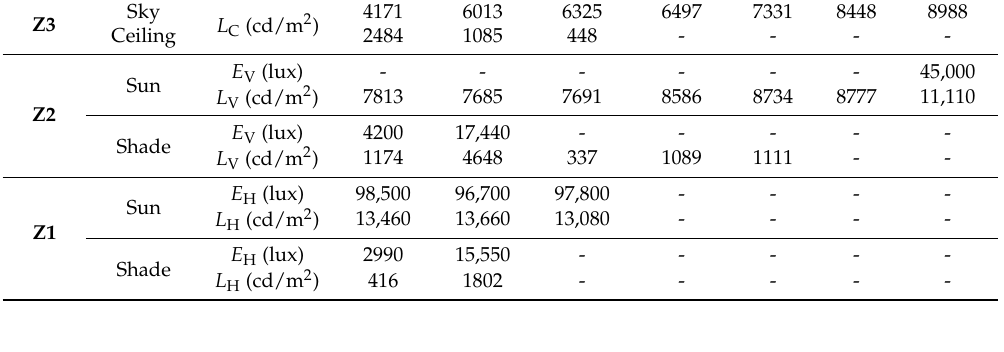
Table 1. Measures of luminance (cd/m 2 ) and illuminance (lux) for Case E.1 for exterior.